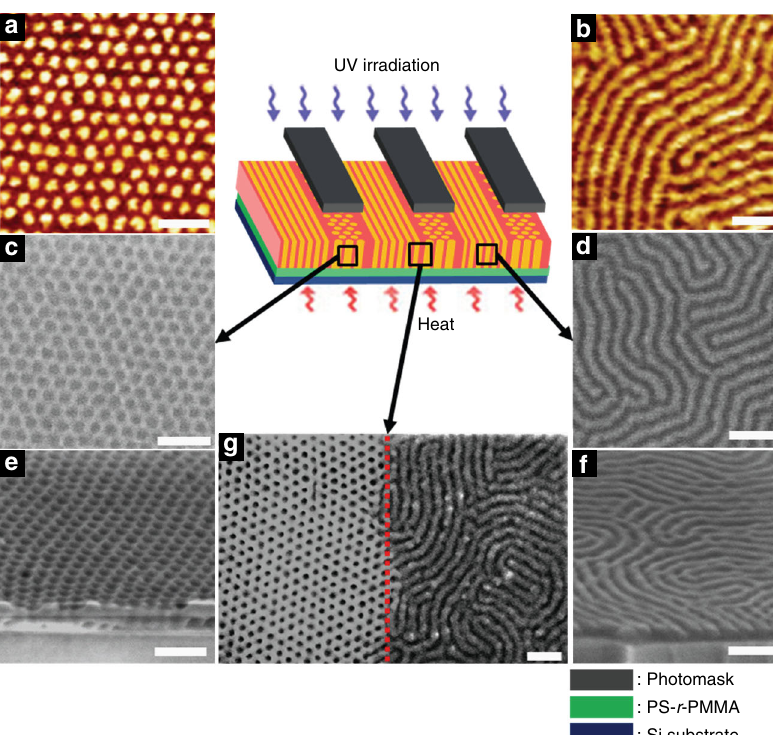
Fig. 4 Thin fi lm morphology after selective UV exposure. a , c , e Vertically oriented cylindrical nanodomains at unexposed regions and b, d, f vertically oriented lamellar nanodomain at UV exposed regions. a , b Phase contrast AFM images. c , d Plane view and e , f cross-sectional SEM images. g SEM image of the boundary between unexposed and UV exposed regions. All of SEM images are obtained after selective removal of PMMA using O 2 RIE. The thickness of the sample is 57 nm (~2 L 0 ). Scale bar is 100 nm